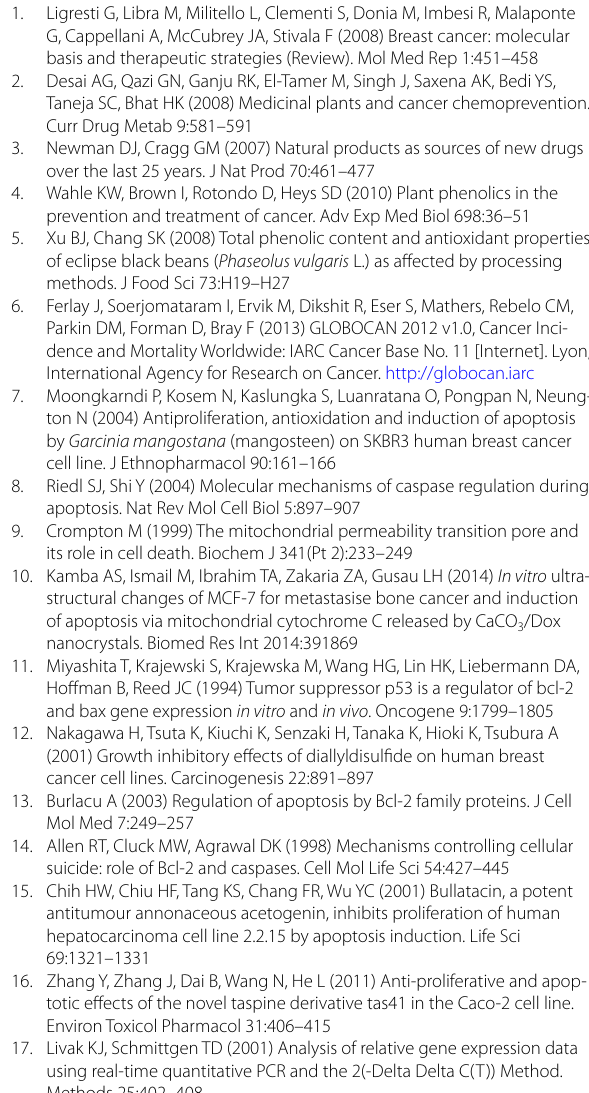
Additional file 1: Figure S1. PI staining assay showing the dead cells when treated with BTB extract (50 and 100 µg/ml) in MCF-7 and MDA- MB231 cells, respectively.